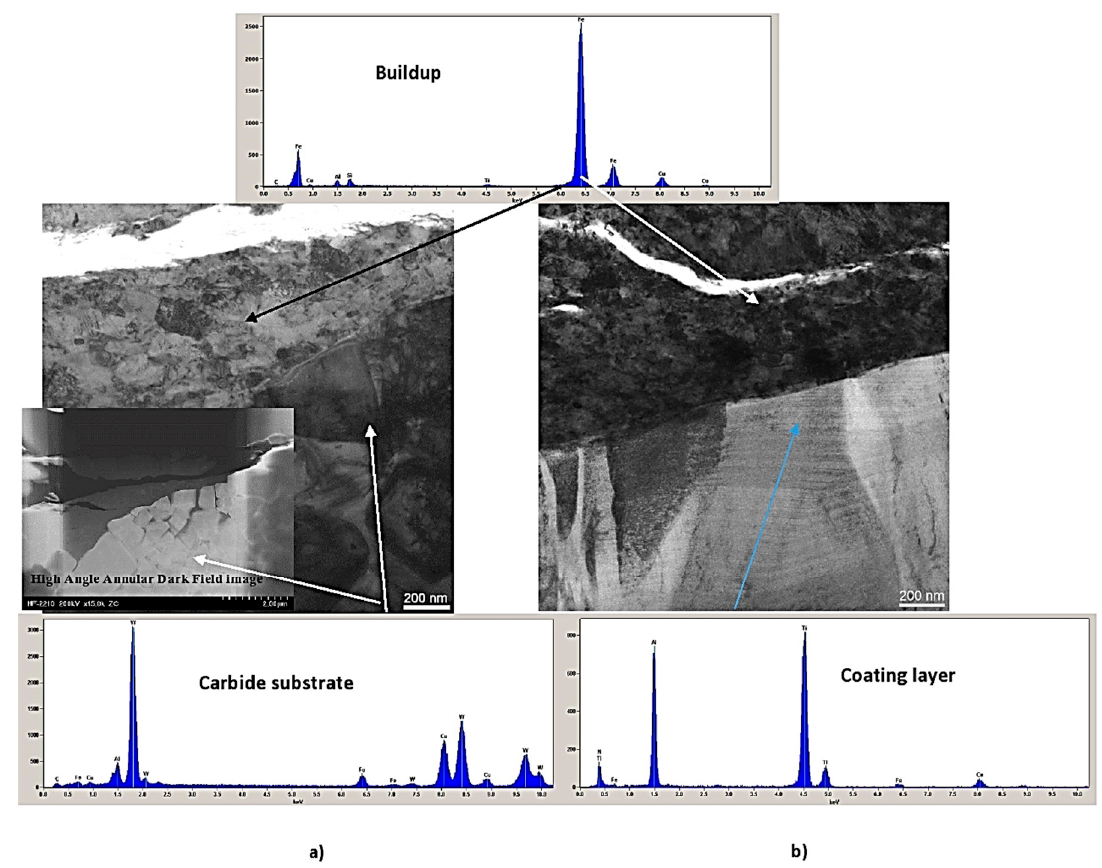
Figure 14. Cross-sectional TEM images of the rake face inserts: ( a ) AlTiN-benchmark coating with, High Angle Annular Dark Field (HAADF) magnified TEM image of ( b ) SFC-AlTiN 10um; length of cut of 400 m. Reproduced from [32], with permission from Elsevier, 2019.